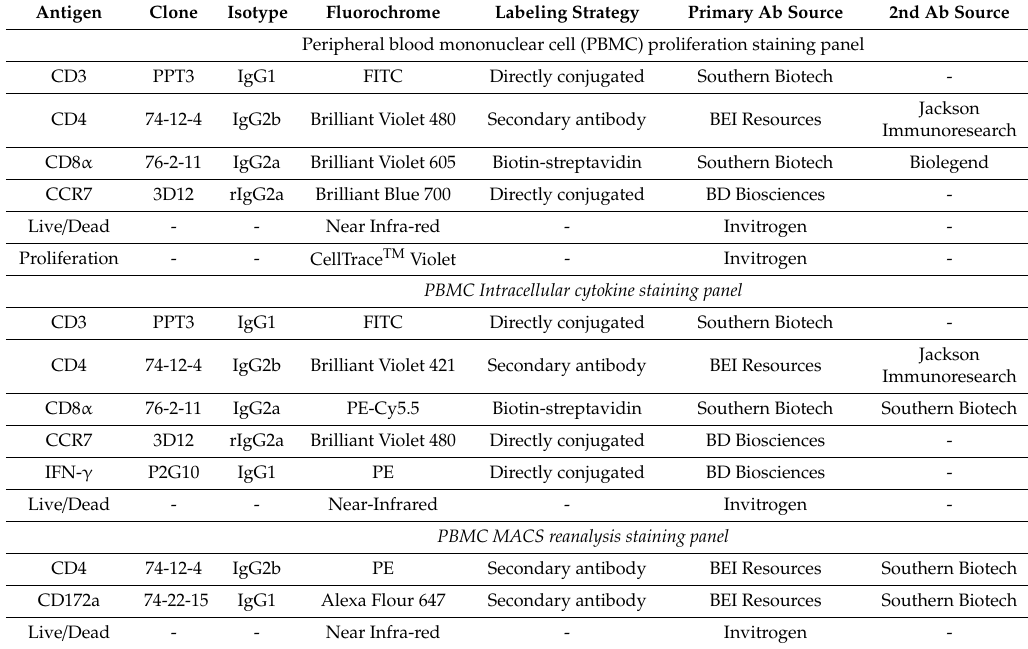
Table 1. Flow cytometry antibody panels.